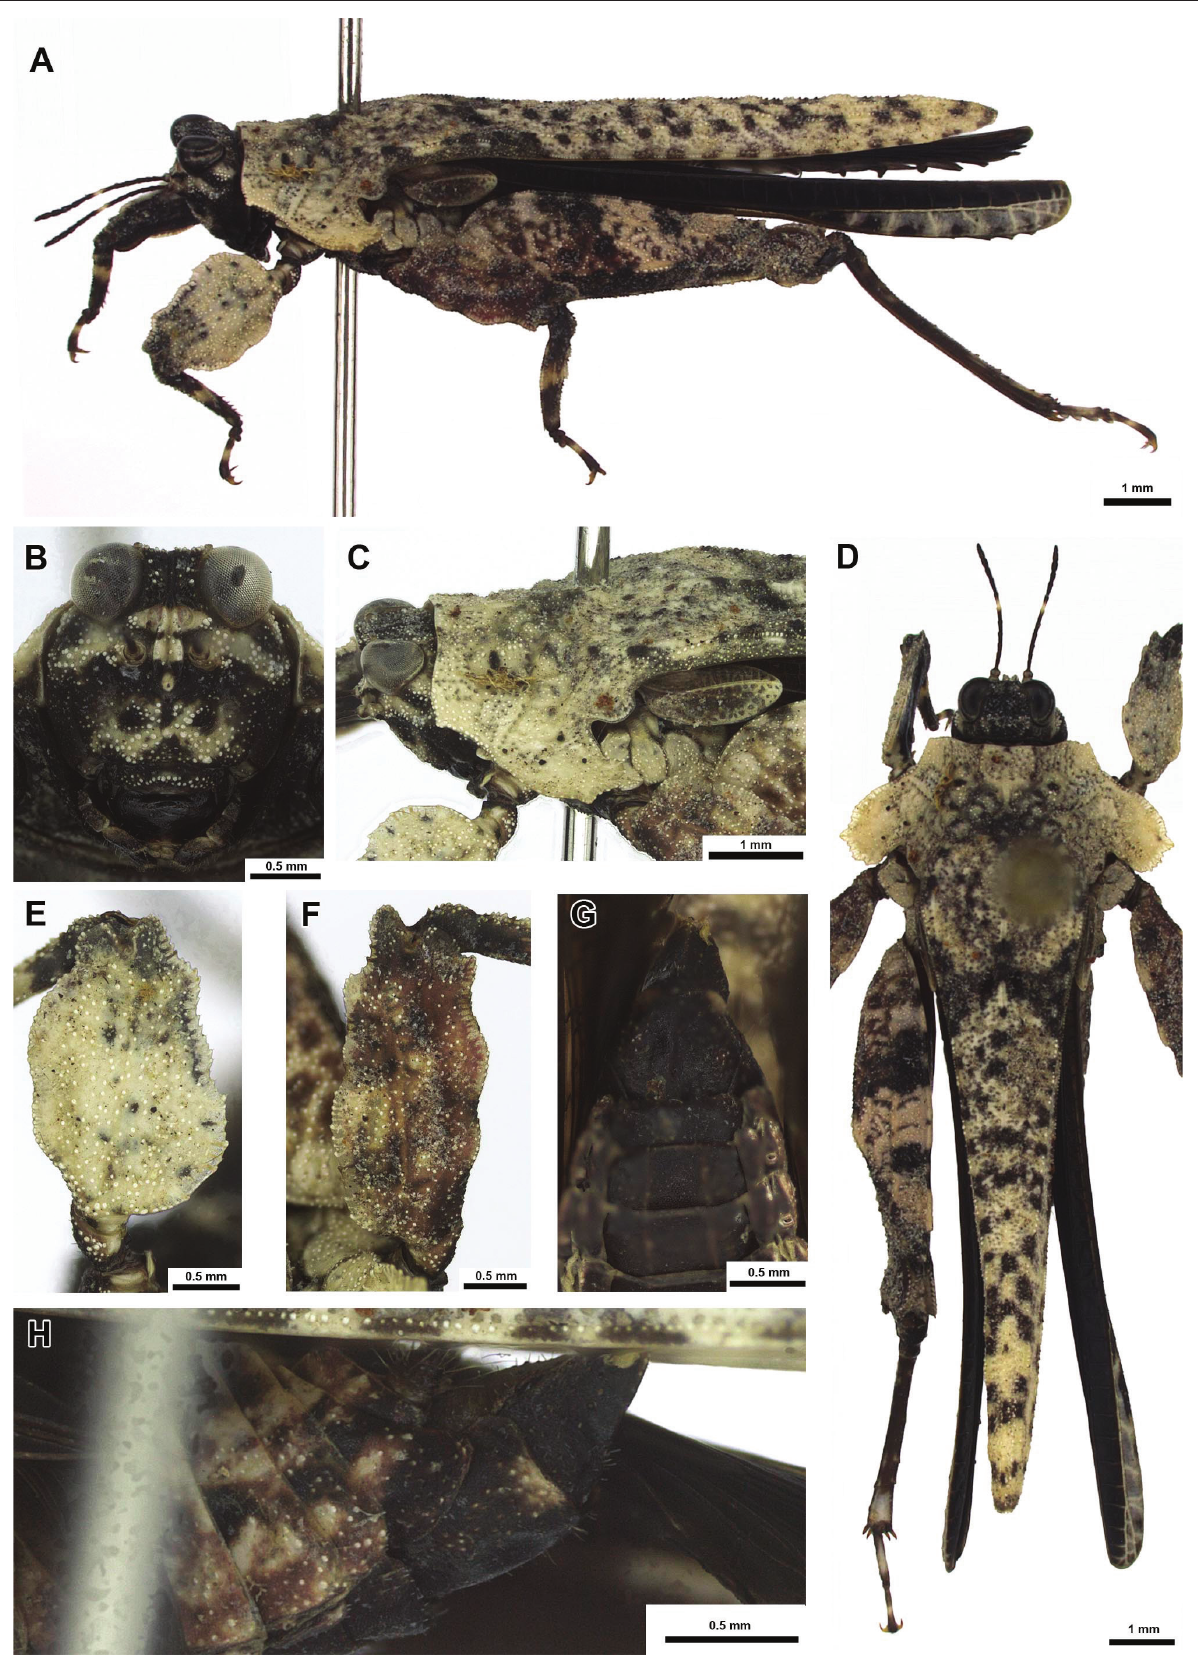
Fig. 2. Amorphopus notabilis (male). A. Habitus in lateral view; B. Frons; C. Head, lateral lobes of pronotum and tegmina in lateral view; D. Habitus in dorsal view; E. Fore-femur; F. Mid-femur; G. Terminalia in ventral view; and H. In lateral